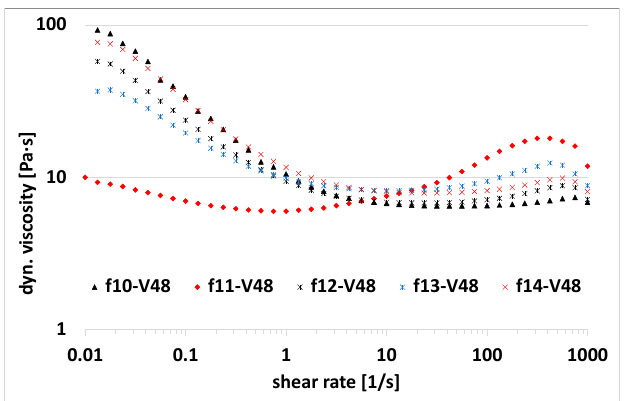
Figure 4. Dynamic viscosity to shear rate; AlN with 48 vol%; comparison of FD (f10) and AD (f11); dispersant system by combination of FD and AD (f12–f14).